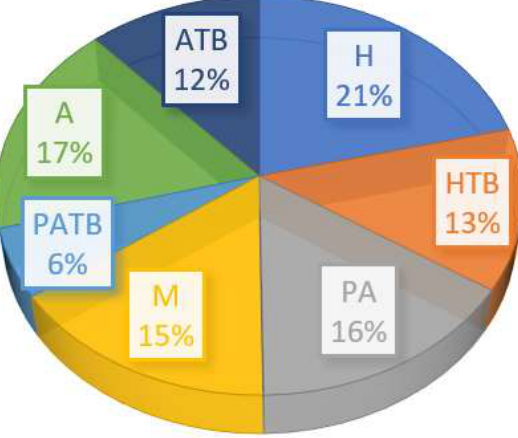
Figure 9. Percentage wise distribution of di ff erent Figure 11. Percentage wise distribution of different compartments.